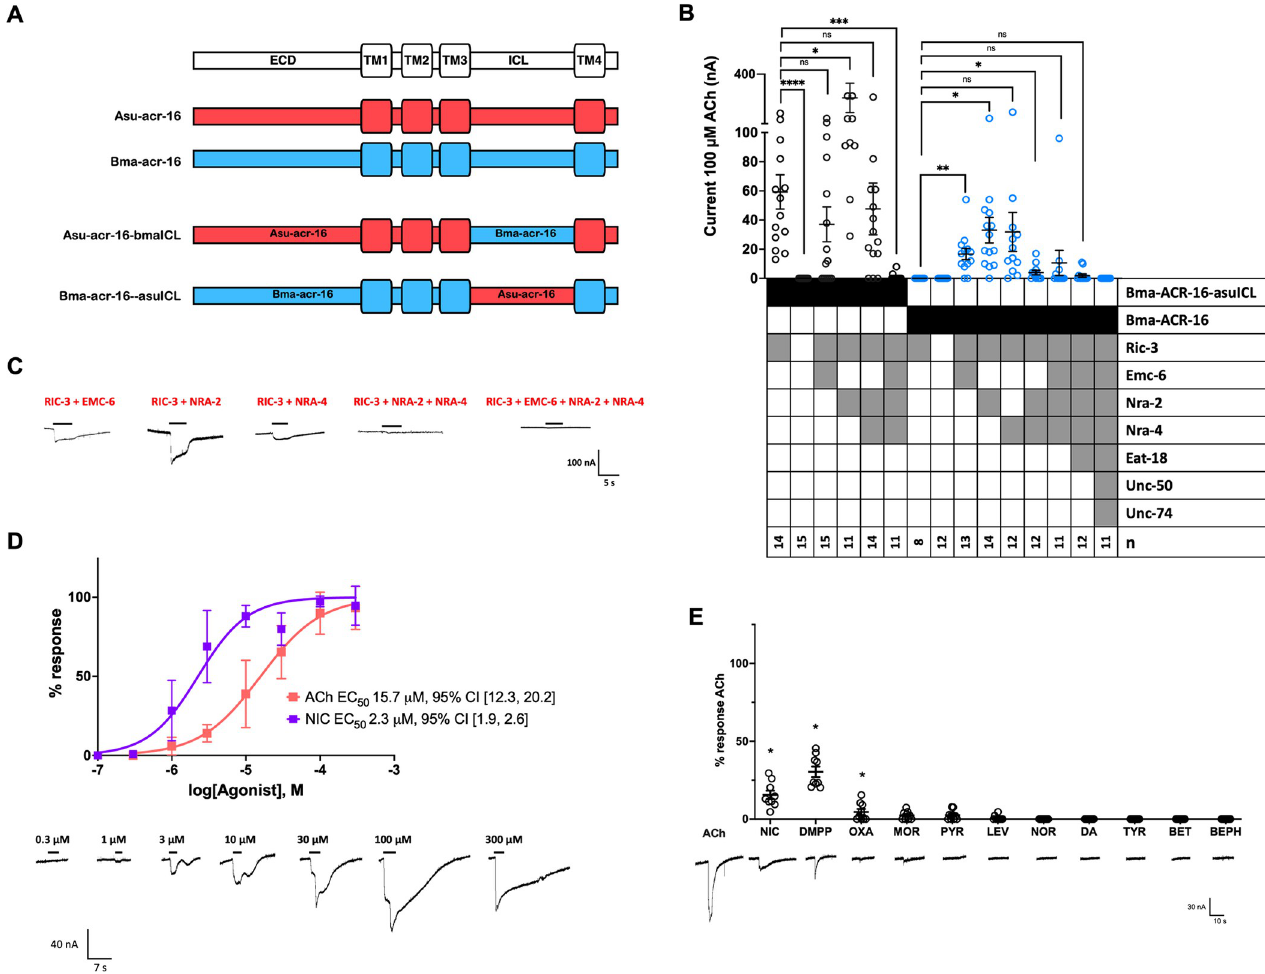
Fig 6. malayi N-AChR requires additional accessory proteins and has unchanged pharmacology compared to other clade III N-AChR. The B . (A) Bma- ACR-16-asuICL and Asu-ACR-16-bmaICL chimeras. (B) Bma-ACR-16-asuICL and Bma-ACR-16 were co-injected with a variety of accessory protein combinations to identify those that produces the highest current response. Bma-ACR-16-asuICL chimera in black, Bma-ACR-16 in blue. Circles represent measured currents from individual oocytes to 100 μ M acetylcholine. Bma-ACR-16 responses (compared to RIC-3) to different combinations of EMC-6, NRA-2 and NRA-4 were: RIC-3 + NRA- 2 (33 ± 9 nA, p < 0.05); RIC-3 + NRA-4 (31 ± 13 nA, p = 0.0698); RIC-3 + EMC-6 (17 ± 4 nA, p < 0.05); RIC-3 + NRA-2 + NRA-4 EMC-6 (11 ± 9 nA, n = 11, p = 0.3108); RIC-3 + NRA-2 + NRA-4 EMC-6 + EAT-18 (2 ± 1 nA, p = 0.2019); and RIC-3 + NRA-2 + NRA-4 + EMC-6 + EAT-18 + UNC-50 + UNC-74 (0 ± 0 nA). Bma-ACR-16-asuICL chimera responses under the different accessory protein conditions were: RIC-3 (59 ± 43 nA); RIC-3 + NRA-2 (256 ± 295 nA, p < 0.05); RIC-3 + NRA-2 + NRA-4 (47 ± 66 nA, p = 0.5887); RIC-3 + EMC-6 (37 ± 46 nA, p = 0.1957); RIC-3 + NRA-2 + NRA-4 + EMC-6 (1 ± 2 nA, p < 0.005). RIC-3 + NRA-2 was therefore included for acetylcholine and nicotine concentration-response curves and for ligand panel analysis. Error bars represent standard error. � p < 0.05; �� p < 0.01; ��� p < 0.0005; ���� p < 0.0001. (C) Sample recordings of Bma-ACR-16 with various accessory protein conditions in response to 100 μ M acetylcholine. (D) concentration-response curves were measured for the Bma-ACR-16-asuICL chimera to compare to the other clade III ACR-16. concentration-response curves for acetylcholine in pink (EC 50 = 15.7 μ M, 95% CI [12.3, 20.2], n = 6) and nicotine in purple (EC 50 = 2.3 μ M, 95% CI [1.9, 2.6], n = 8). Hill coefficients were 1.1, 95% CI [0.85, 1.4] for ACh and 1.3, 95% CI [1.0, 1.6] for NIC. Sample recording to acetylcholine is shown. Similar EC 50 to other clade III ACR-16 indicates the small currents obtained with Bma-ACR-16 is not due to changes in ligand affinity. Error bars represent standard error. (E) Bma-ACR-16-asuICL chimera response to 100 μ M ligands relative to acetylcholine. Bma-ACR-16-asuICL chimera had a comparable response profile to other N-AChR. Relative responses to ACh were NIC (16 ± 3% p < 0.05), DMPP (30 ± 3%, p < 0.05), OXA (5 ± 2%, p < 0.05), MOR (2 ± 1%, p < 0.05), and PYR (3 ± 1%, p < 0.05), LEV (1 ± 1%, p < 0.05),) and no responses to NOR (0 ± 0%, p < 0.05), DA (0 ± 0%, p < 0.05), BET (0 ± 0%, p < 0.05), BEPH (0 ± 0%, p < 0.05) and TYR (0 ± 0%, p < 0.05). Sample recording to each ligand is shown. Similar ligand response profile to other clade III N-AChRs indicates the small currents obtained with Bma-ACR-16 is not due to changes in ligand preference. Error bars represent standard error. � p <